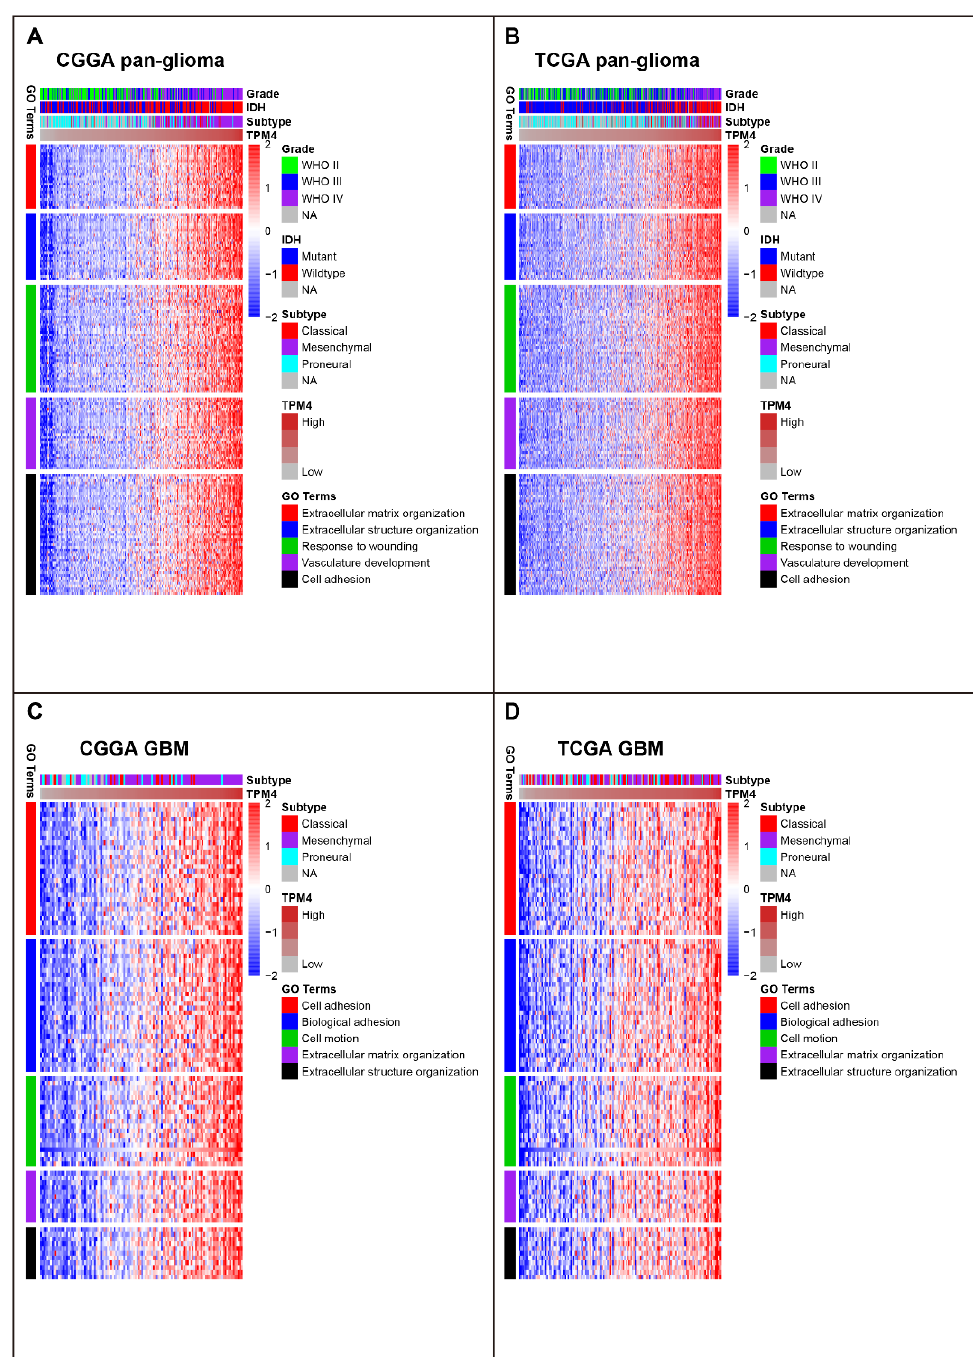
Figure 2. Gene Ontology (GO) analysis for TPM4 in pan-glioma ( A , B ) and GBM ( C , D ). Statistics value of pan-glioma GO: extracellular matrix organization (gene count = 25, p = 2.57 × 10 −18 ), extracellular structure organization (gene count = 26, p = 1.44 × 10 −14 ), response to wounding (gene count = 42, p = 1.47 × 10 −12 ), vasculature development (gene count = 28, p = 7.76 × 10 −12 ), and cell adhesion (gene count = 47, p = 1.75 × 10 −11 ). Statistics value of GBM GO: cell adhesion (gene count = 28, p = 6.82 × 10 −16 ), biological adhesion (gene count = 28, p = 7.03 × 10 −16 ), cell motion (gene count = 19, p = 1.45 × 10 −10 ), extracellular matrix organization (gene count = 11, p = 3.78 × 10 −10 ), and extracellular structure organization (gene count = 11, p = 3.04 × 10 −8 ). NA: not available.